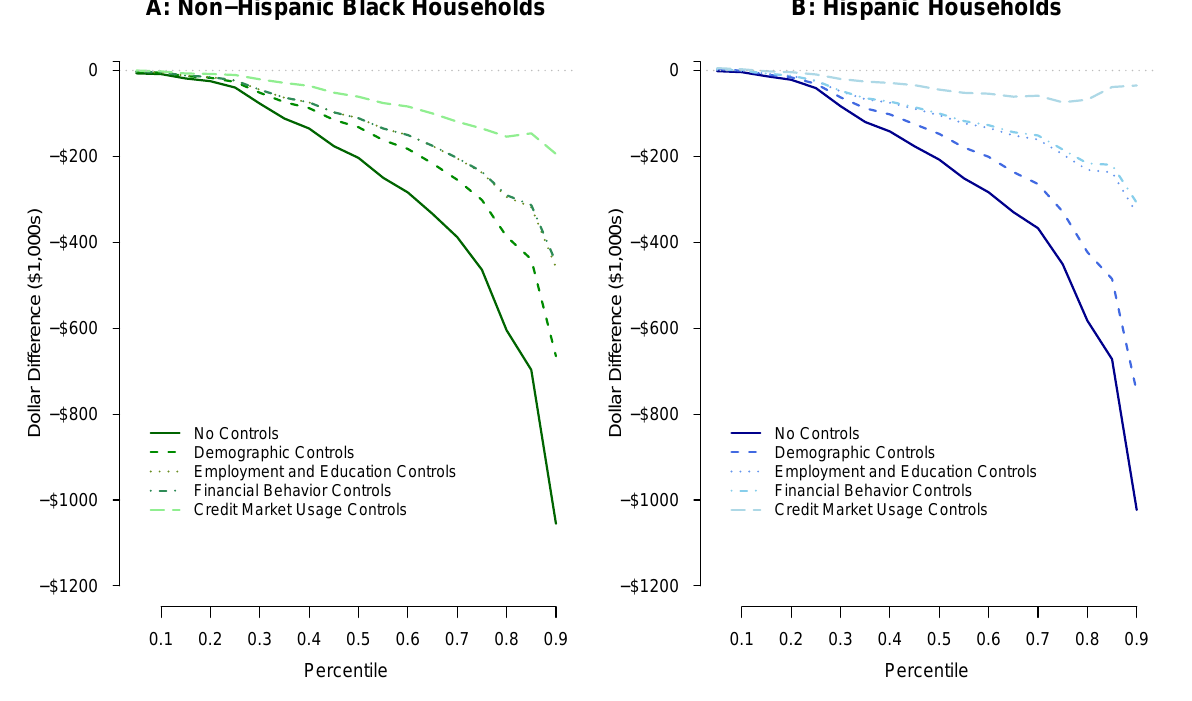
Figure 3: Difference in net worth by race, ethnicity, and percentile, 1998–2013, controls. Notes: Figure 3 presents the unconditional difference in net worth across the distribution for non-Hispanic black households (Panel A) and Hispanic households (Panel B) when compared to non-Hispanic white households in 2013 U.S dollars, conditional on four sets of